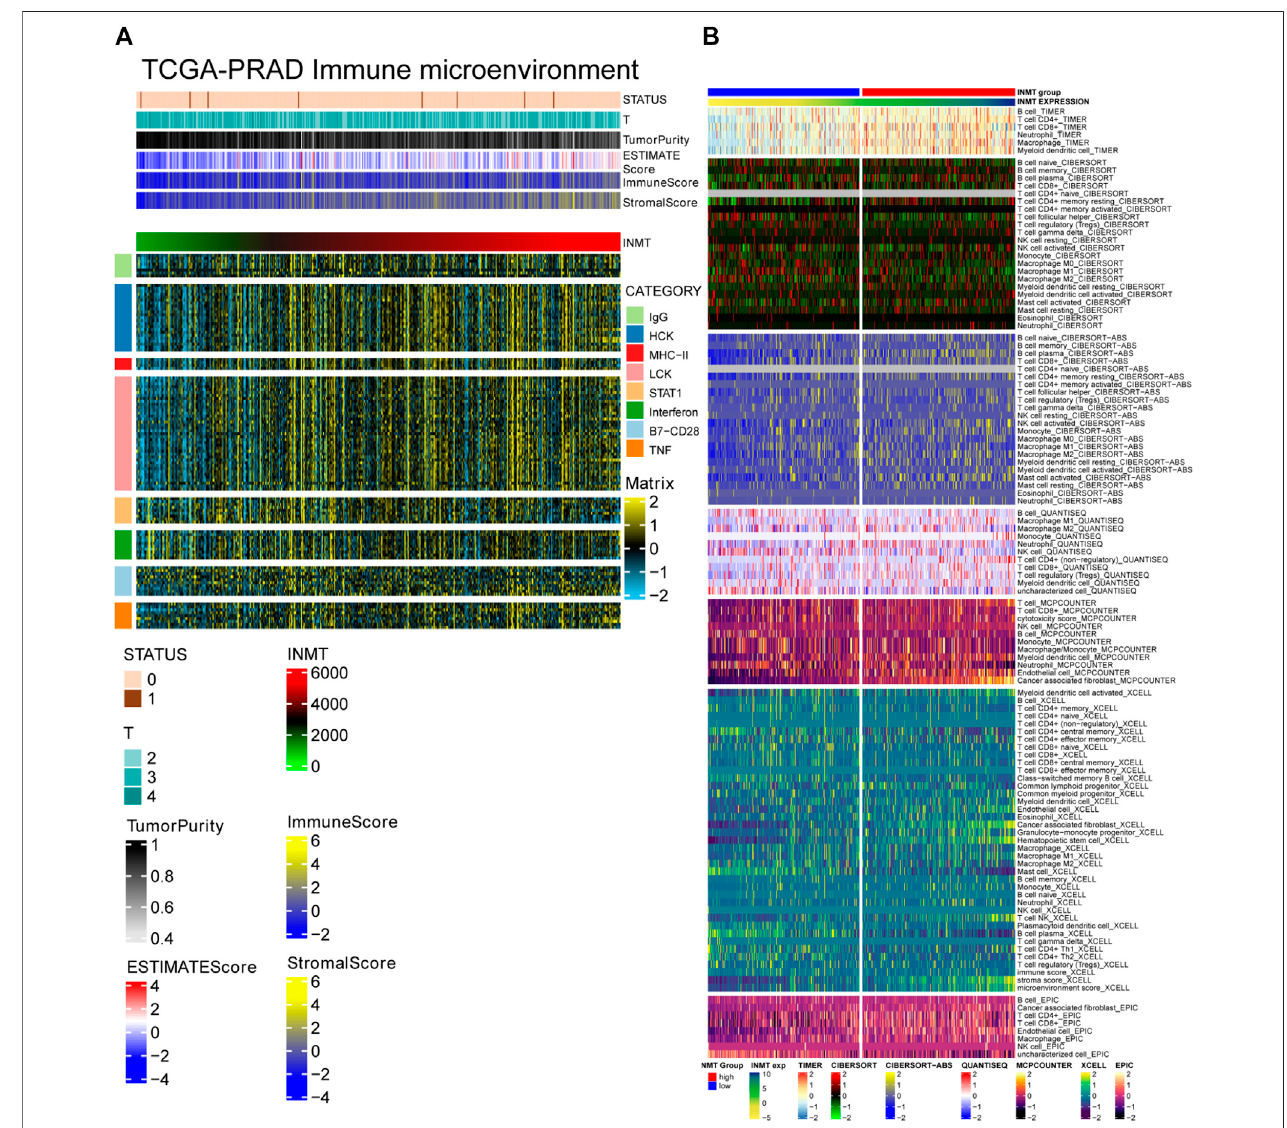
FIGURE 5 | (A) Correlation between the expression level of INMT and tumor stage, tumor purity, ESTIMATE score, immune score, stormal score and immune response intensity (expression of eight immune-related genes). (B) The proportion of different immune cells in the two subgroups of INMT expression based on TIMER, CIBERPORT, CIBERPORT-ABS, QUANTISEQ, MCPcounter, XCELL and EPIC algorithms.